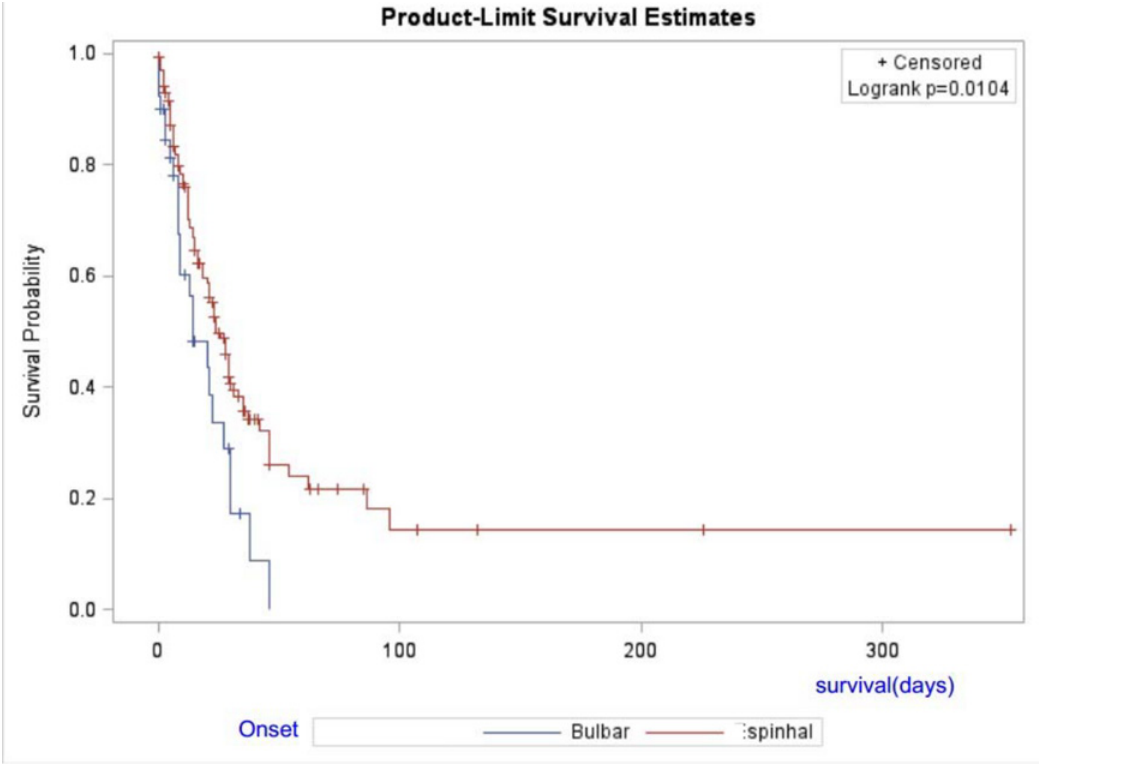
Fig 2. Survival of Amyotrophic Lateral Sclerosis patients taking riluzole in Federal District.